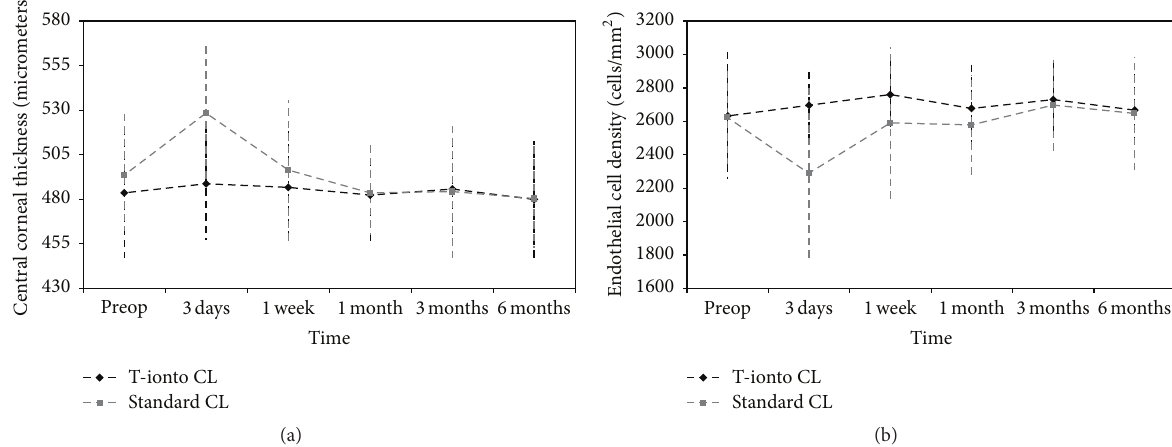
Figure 6: ((a) and (b)) Graphs showing central corneal thickness (CCT, 𝜇 m) and endothelial cell density (ECD, cells/mm 2 ) compared with baseline at 3 days, 1 week, and 1, 3, and 6 months after T-ionto CL (black curve) and standard CL (grey curve), respectively. Bars indicate ± standard deviation. No significant changes of CCT and ECD were found after T-ionto CL during 6 months of follow-up. Major differences between treatments in the early postoperative period are due to consequences of epithelial debridement and direct UV-A irradiation of the stroma thinned by hypertonic riboflavin